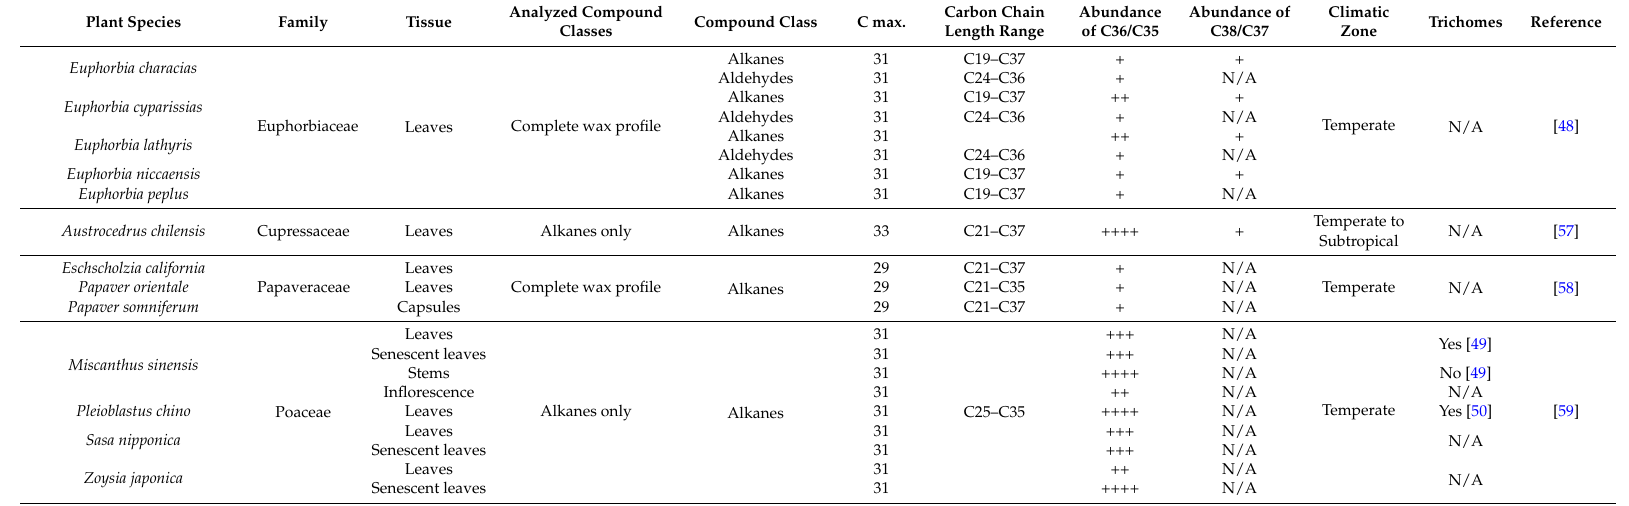
Table 2. Survey of plant species reported to contain cuticular wax compounds with extra-long hydrocarbon chains (C 35+ ). Chain length ranges, most abundant chain lengths (C max.), and relative abundances of C 35+ compounds within respective compound classes (+: 0–1%; ++: 1–5%; +++: 5–10%; ++++: >10%) are shown. Comprehensiveness of respective chemical analyses is indicated by information which compound classes were included in the analyses. As additional information, organs from which extra-long compounds were extracted are given, the occurrence of trichomes on respective tissues is assessed where possible, and climatic zones are listed for each